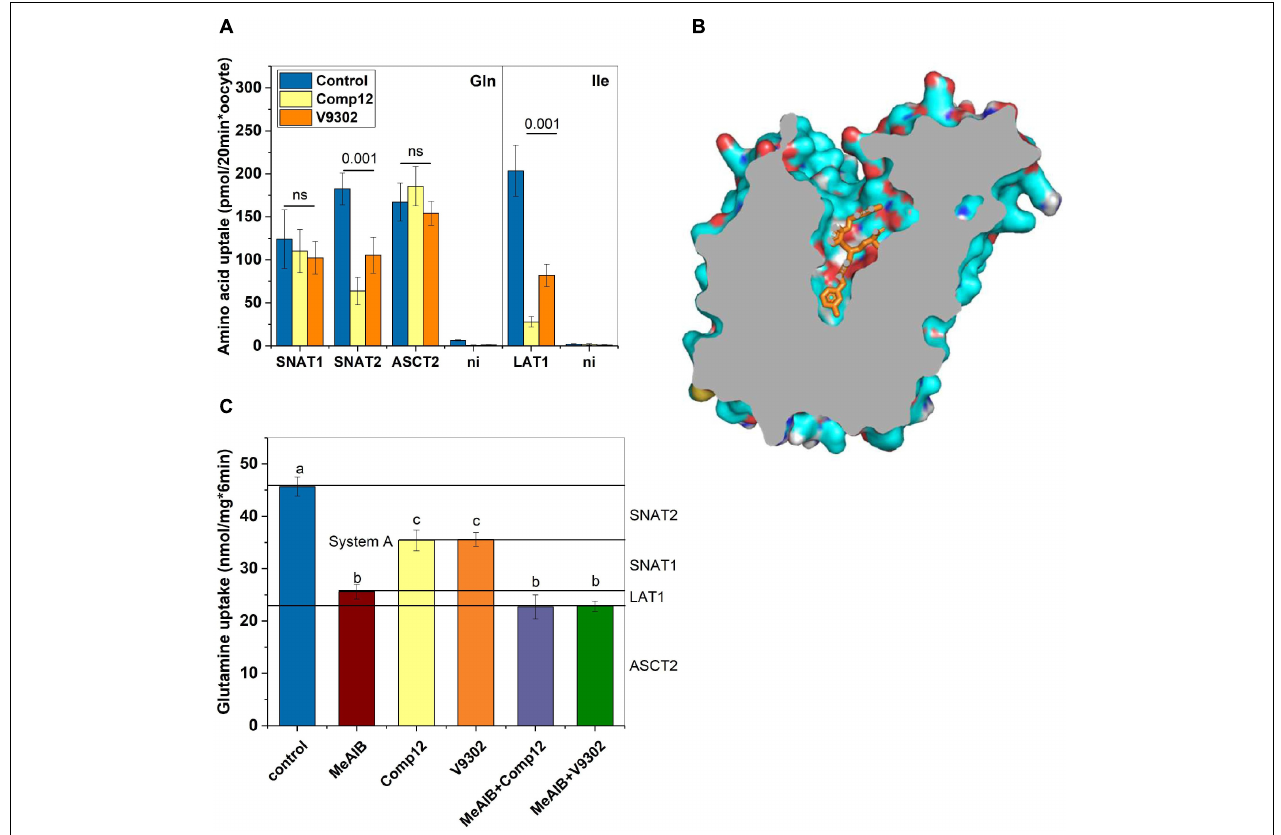
FIGURE 4 | Evaluation of inhibitor specificity. (A) Transporters hSNAT1, hSNAT2, hASCT2, and h4F2hc/rLAT1 were expressed in Xenopus laevis oocytes. Transport experiments were performed 4–7 days after injection of the corresponding cRNAs. Glutamine uptake was used to measure hSNAT1, hSNAT2, and hASCT2 activity, while isoleucine transport was used to measure h4F2hc/rLAT1 activity. Uptake was measured in the presence or absence of inhibitors as indicated ( n = 8 for each transporter) in three batches of oocytes. (B) A homology model of human LAT1 was generated after alignment with the E. coli arginine–agmatine antiporter (PDB 5J4I). Docking of V-9302 was performed using PyRX. One of several energetically favorable poses is shown. (C) Delineation of glutamine transport pathways in 143B osteosarcoma cells. The contributions of SNAT1, SNAT2, ASCT2, and LAT1 were deduced using combinations of inhibitors ( n = 6). Groups that were different ( p < 0.001) have different letter